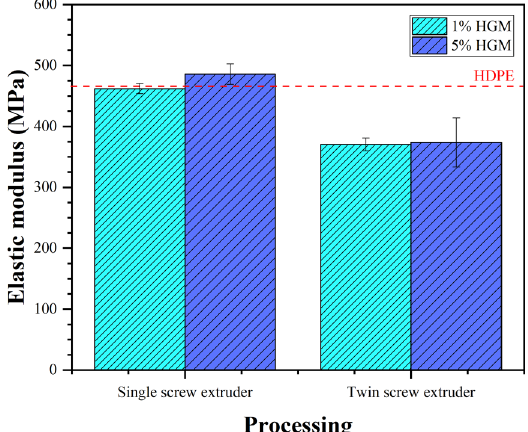
Figure 4. Elastic modulus x